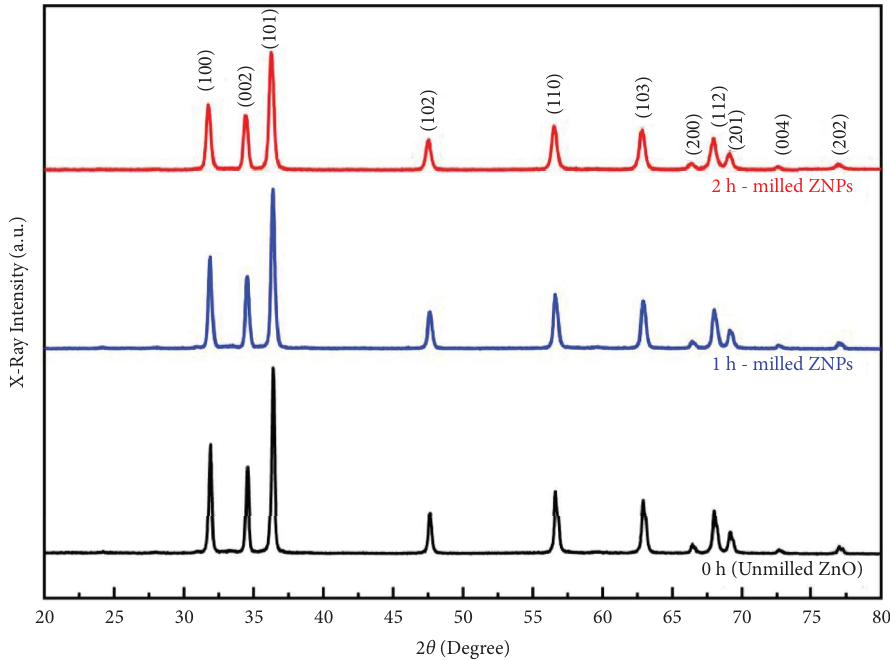
Figure 4: X-ray difraction peaks of ZnO before and after the HSBM